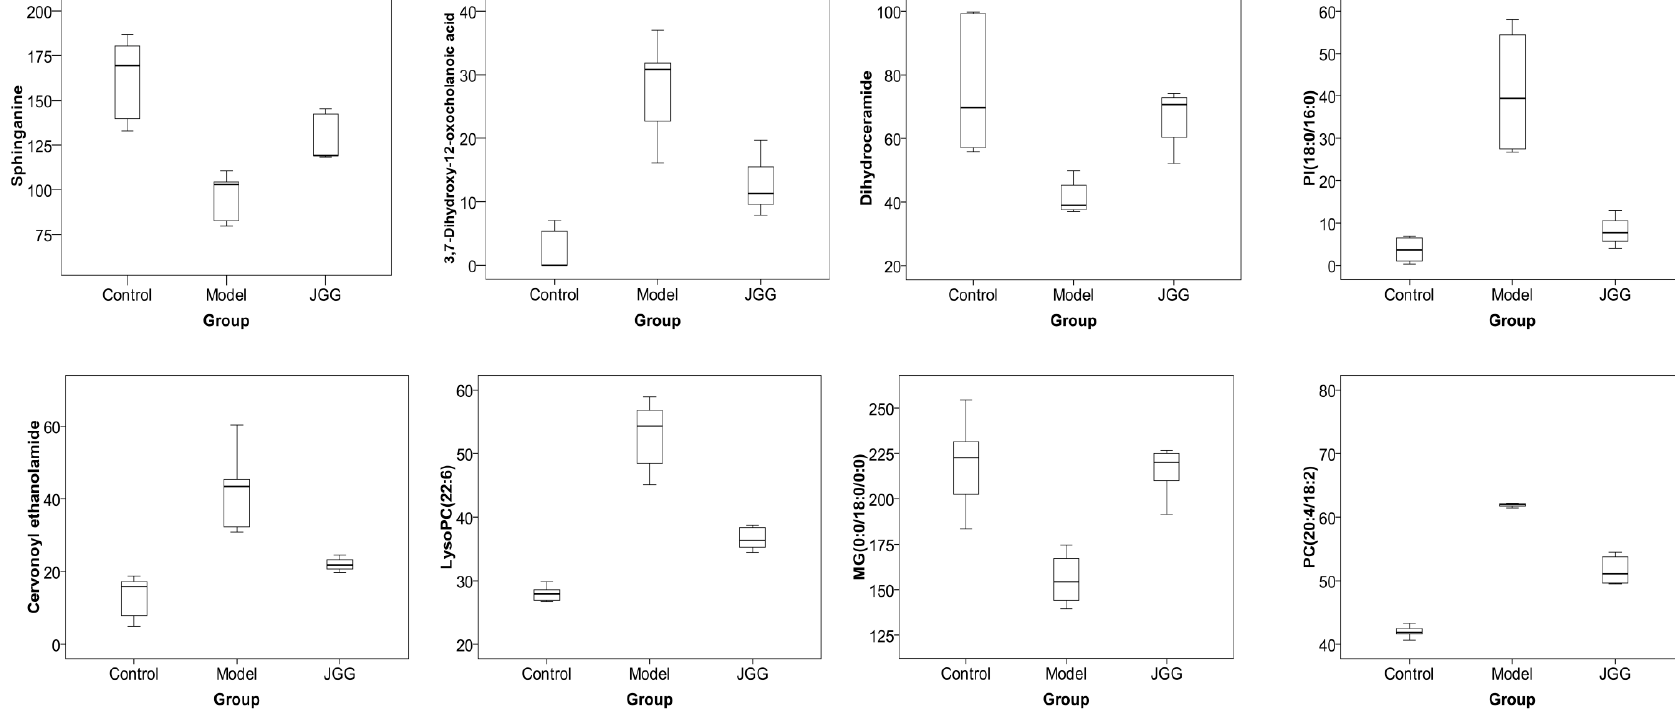
Figure 7. The box plots of eight drug target markers.